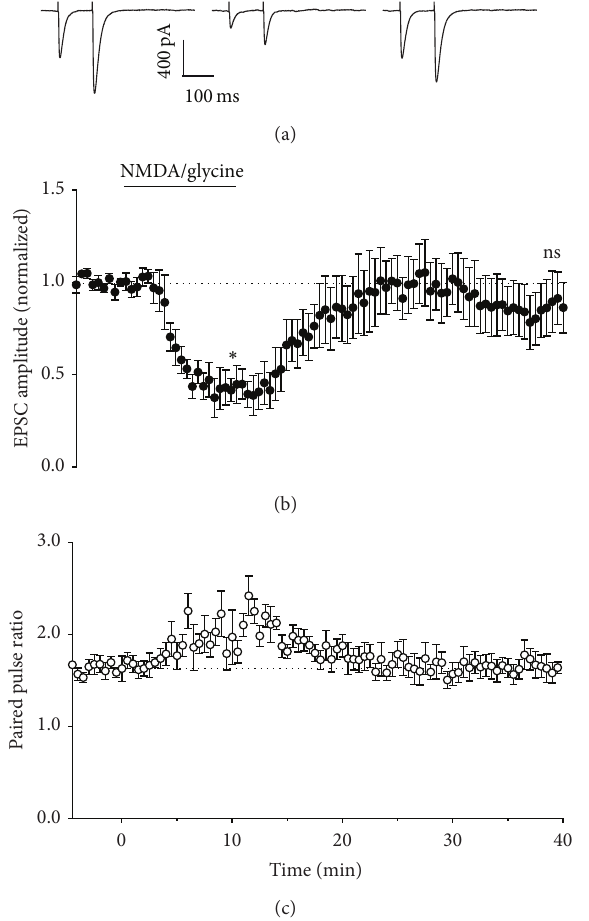
Figure 9: Effect of activation of NMDA receptors on Bergmann glial responses. (a) Representative whole-cell recordings of ESCs generated by paired pulse stimulation (100ms interval) of parallel fibres in transverse cerebellar slices at 0.033 Hz before (first panel), after 10 minutes incubation with 30 𝜇 M NMDA and 10 𝜇 M glycine (second panel), and after 30 minutes of washout (third panel). (b) Timecourseof 30 𝜇 MNMDAand10 𝜇 Mglycine effect onamplitude of the first pulse in each pair, with NMDA and glycine incubation at the time indicated by the bar. Data are mean ± s.e.m. from 6 cells. ∗ 𝑃 = 0.0003 , † 𝑃 = 0.0084 , one-sample 𝑡 -test. (c) Time course of 30 𝜇 M NMDA and 10 𝜇 M glycine effect on paired pulse ratio, with NMDA and glycine incubation at the time indicated by the bar. Data are mean ± s.e.m. from 6